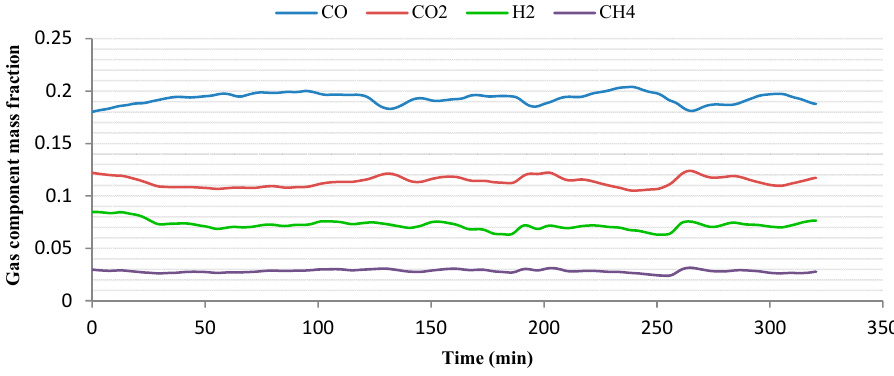
Figure 3 . Mass fraction variation with time in the experimental study. Figure 3. Mass fraction variation with time in the experimental study.